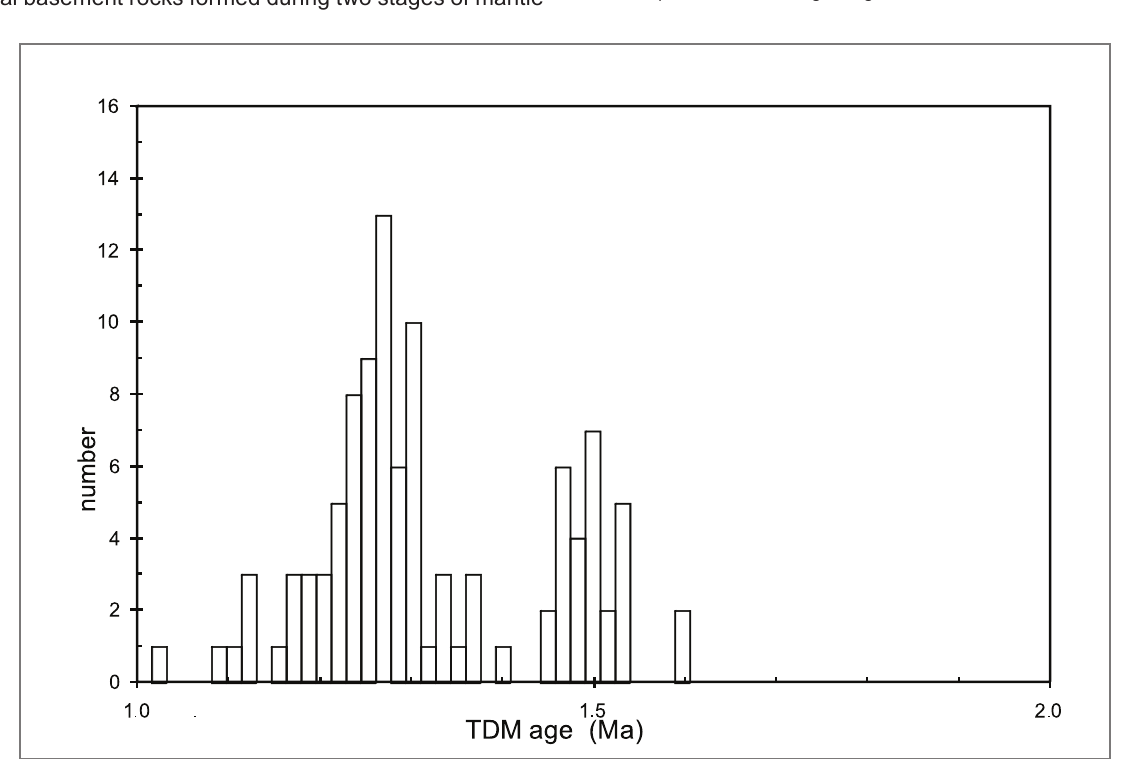
FIGURE 8 – Histogram with density plot of TDM Hf ages where two groups of ages may be